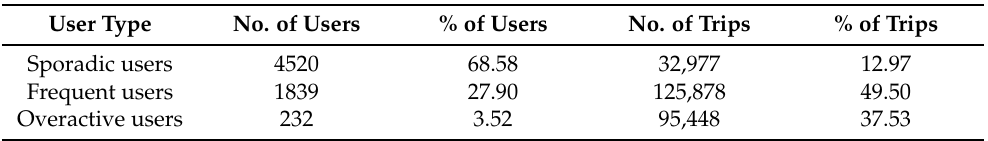
Table 3. Information on the number and percentage of users and trips in each category of user